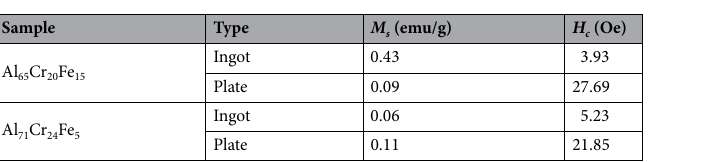
Table 1. The magnetic properties of Al 65 Cr 20 Fe 15 and Al 71 Cr 24 Fe 5 determined by analysis of the magnetization changes as a function of magnetic field ( M s , saturation magnetization; H c , coercivity).